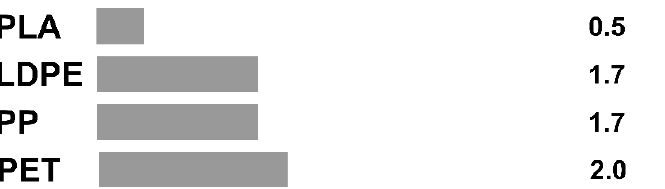
Figure 5. CO 2 equivalent emissions in kg per kg of polymer—cradle to gate. Adapted from BioApply.